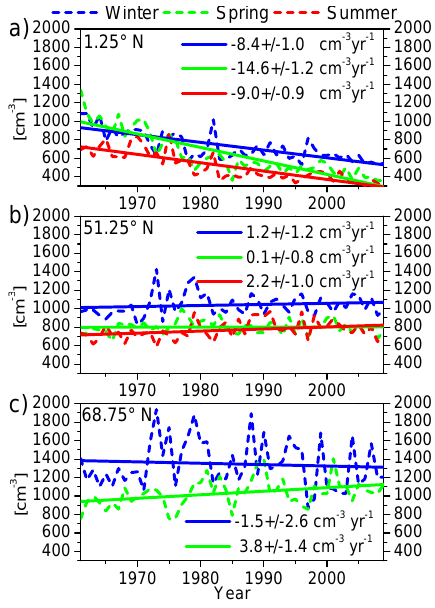
Figure 1. Long-term variations (dashed lines) and corresponding linear trends (solid lines) in the seasonally averaged nighttime mean concentration of the OH ∗ peak at low (a) , middle (b) , and high v = 6 (c) northern latitudes for winter (blue lines), spring (green lines), and summer (red